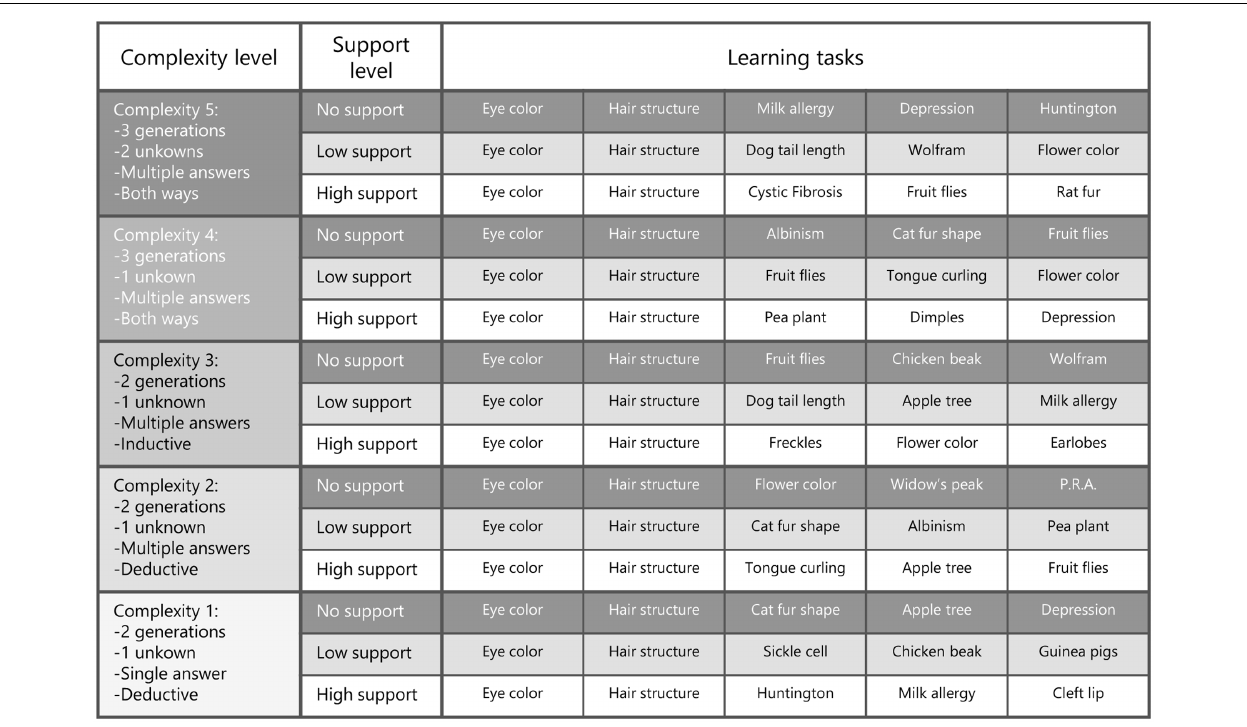
FIGURE 1 | Task database containing the 75 problem-solving tasks showing the different levels of complexity, different levels of support, and the different surface features of the learning tasks (Raaijmakers et al., unpublished).